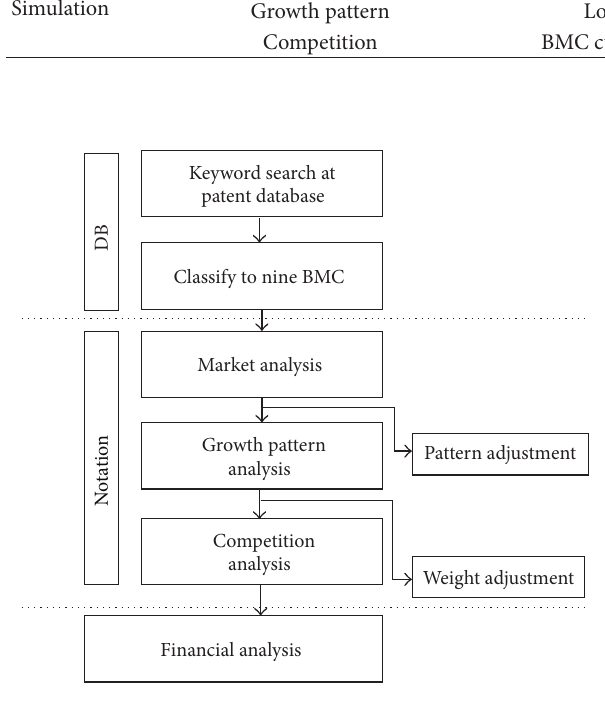
Figure 1: R&D business aspect evaluation